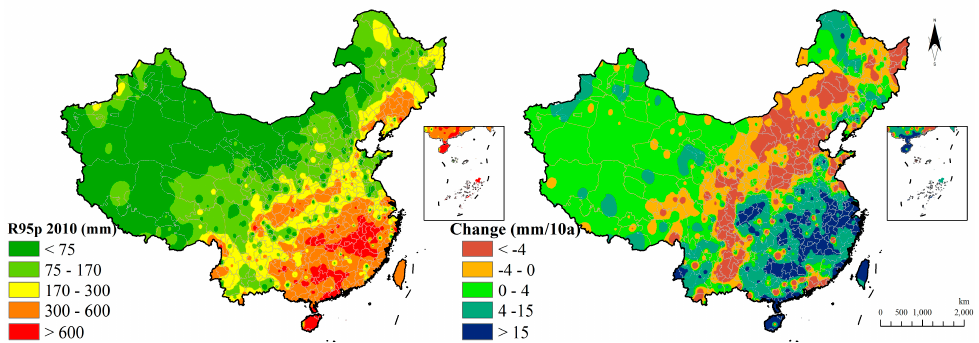
Figure 15. Very wet days indicator distribution and change.